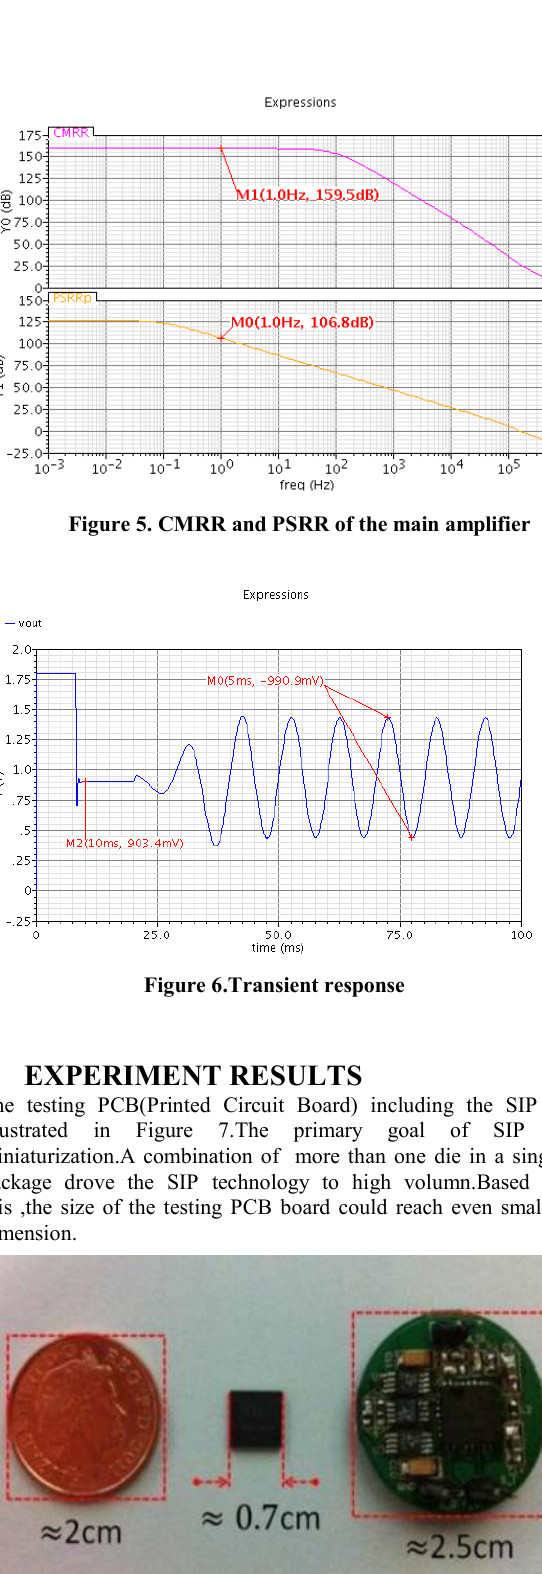
Figure 7.the testing PCB and chip compared with one penny